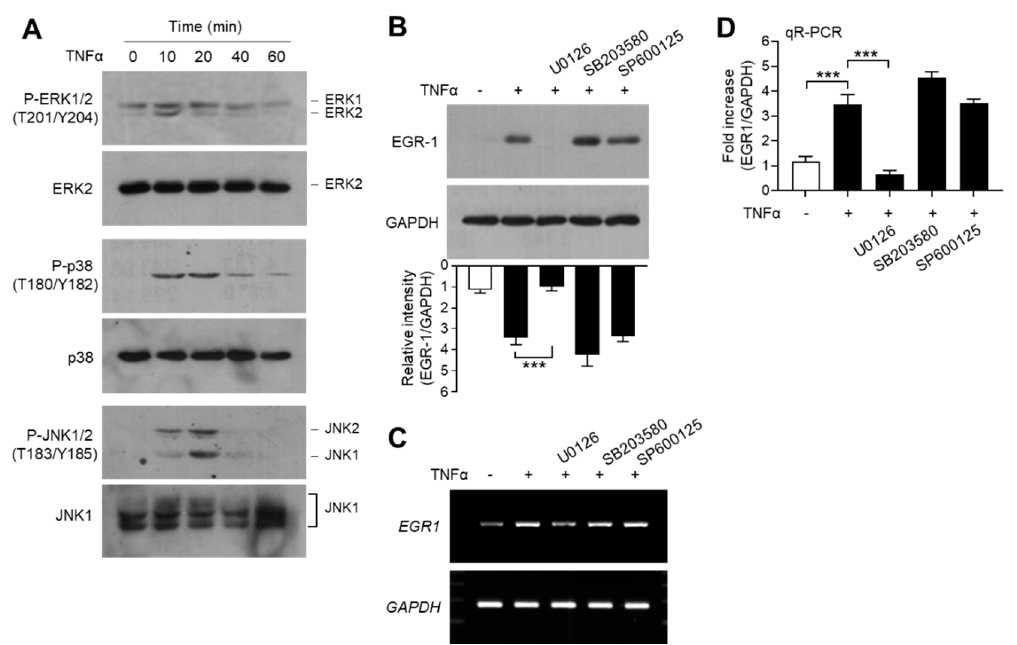
Figure 6. Effect of mitogen-activated protein kinase (MAPK) inhibition on EGR-1 expression. ( A ) Figure 6. E ff ect of mitogen-activated protein kinase (MAPK) inhibition on EGR-1